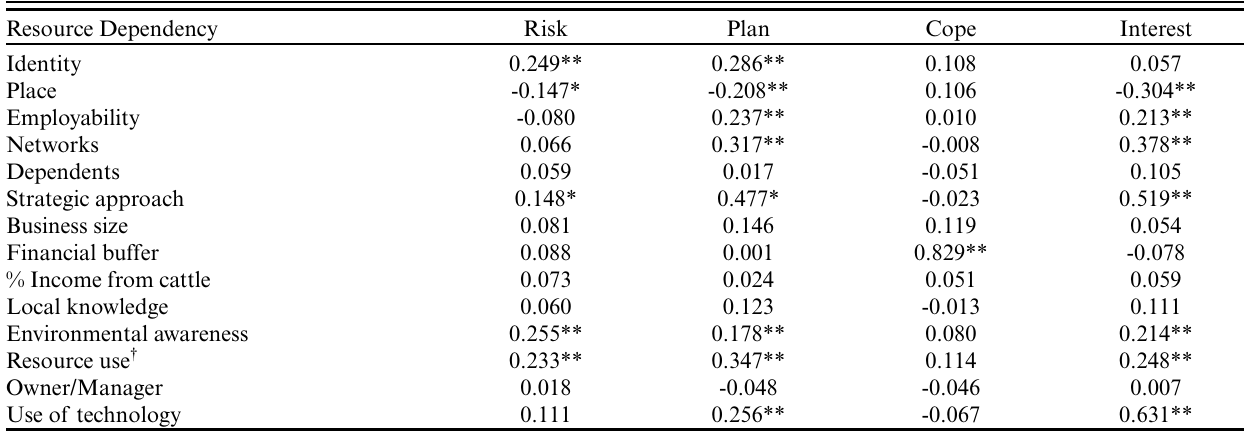
Table 3 . The relationship between resource dependency and each of the four dimensions of adaptive capacity within producers of northern